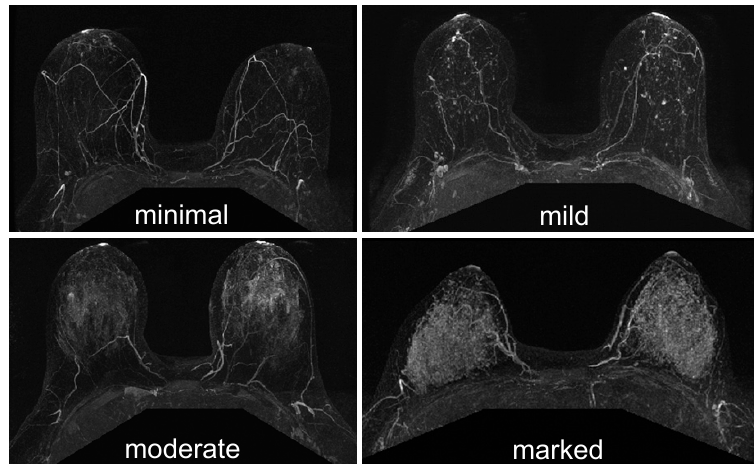
Figure 4. Examples from the Breast Imaging-Reporting and Data System (BI-RADS) lexicon for contrast-enhanced MRI, showing the different degrees of background parenchymal enhancement (BPE) in the breast: minimum, mild, moderate, and marked enhancement.